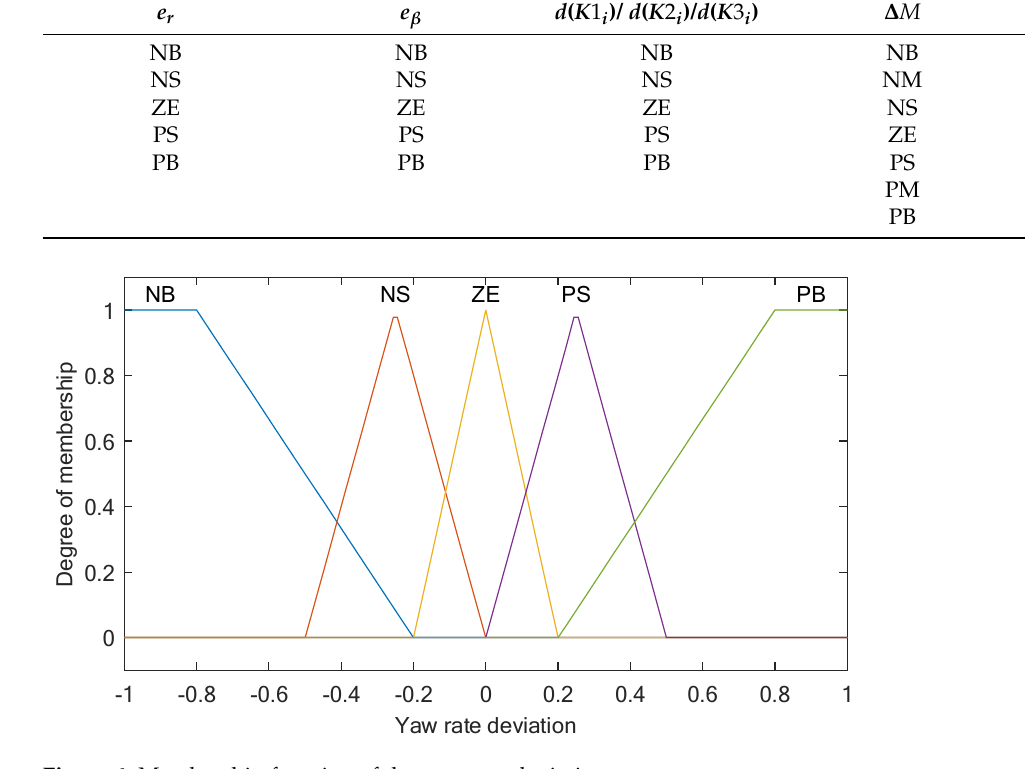
Figure 6. Membership function of the yaw rate deviation.